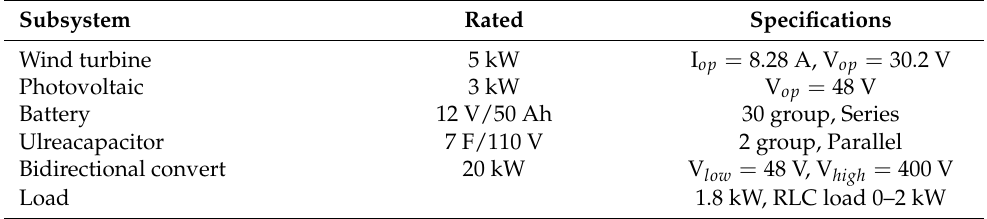
Table 1. Microgrid system